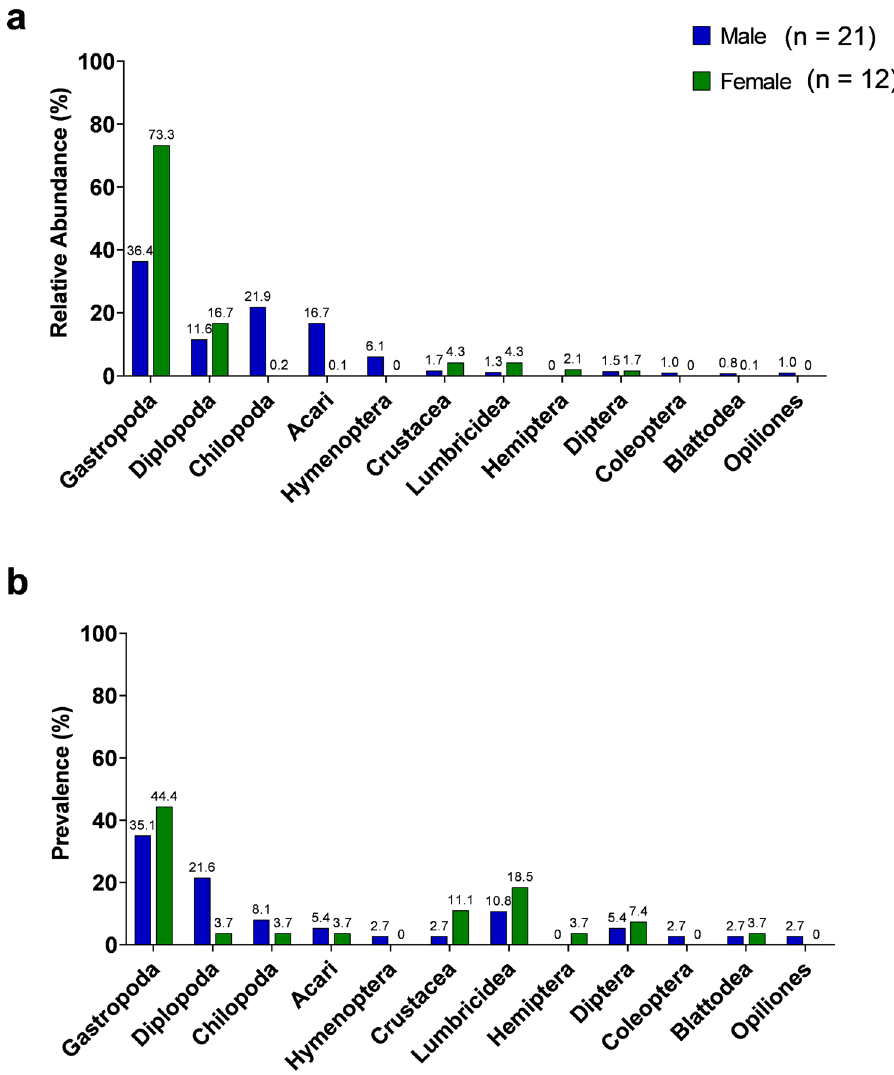
Figure 1. Diet composition between sexes. ( a ) Relative abundance of fire salamander diet in male and female animals. Relative abundance: sub-OTU reads of each prey category to the amount of reads assigned to total prey. ( b ) Prevalence of prey taxa in male and female animals. Prevalence: the number of samples in which a prey category was found